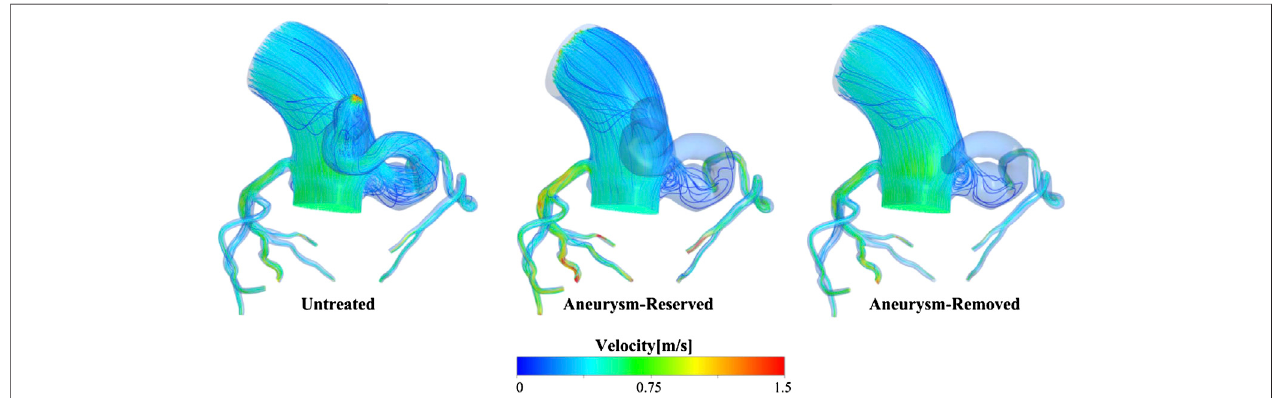
FIGURE 4 | Streamlines of case 1 at systolic